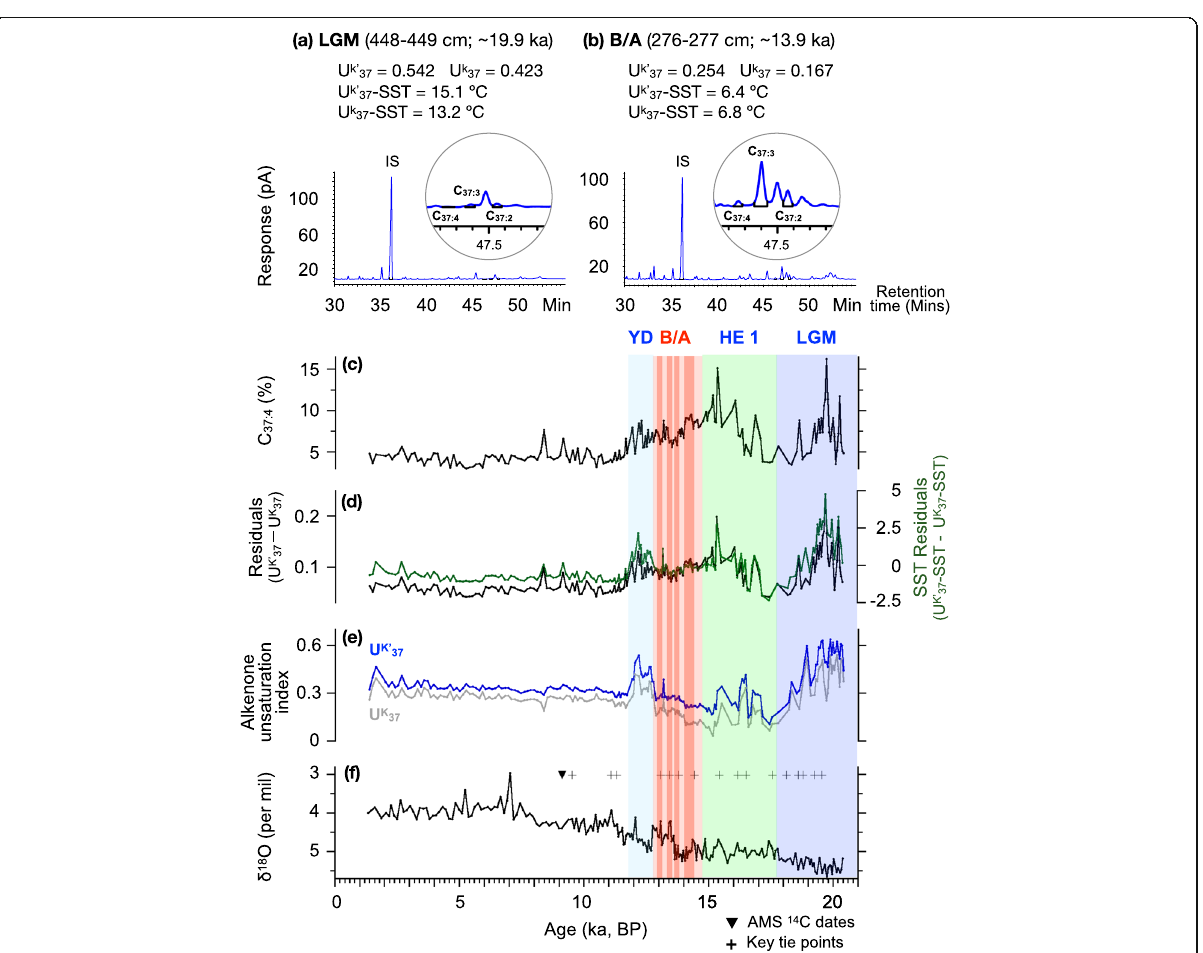
Fig. 3 Example chromatograms of glacial alkenone warming and downcore alkenone-related variations since the last glacial. Representative GC- FID chromatograms of alkenone-containing sediment extracts from examples of a LGM and b the B/A interstadial are illustrated. Alkenone peak assignation: IS/Internal standard, C 37:4 , C 37:3 , C 37:2 . c freshwater signals C 37:4 , d residuals in alkenone unsaturation index (U k ’ 37 - U k 37 ; black) and alkenone SSTs (red), and e alkenone unsaturation index U k ’ 37 (blue) and U k 37 (gray), all are plotted against age and compared with the